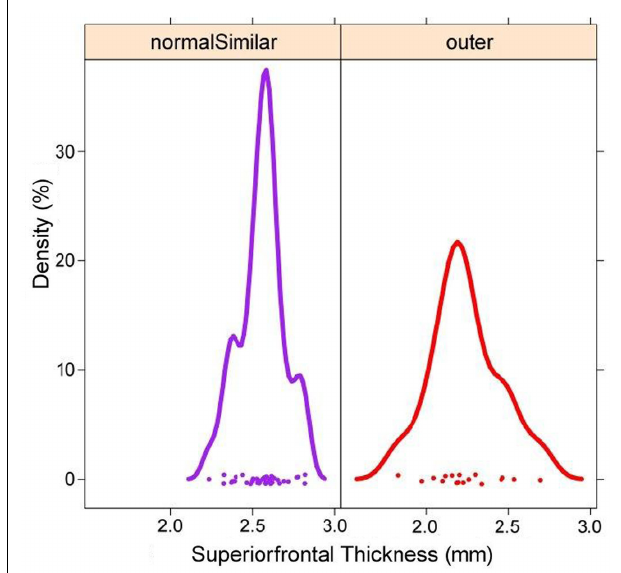
FIGURE 8 | Brain region-specific exploration of the data using linked plots painted by user-defined group. Corresponding to the data represented in Figure 7 , but focusing only on the superior frontal gyrus sub-volumes, histograms for the group consisting of mostly healthy subjects is given (left), while a red group is largely comprised of patients with Alzheimer’s Disease.Thus, from the examination of how brain morphometry clusters in a derived feature space explored using INVIZIAN, a user can quickly and interactively discover that normal subjects exhibits a larger mean thickness in frontal cortices than do patients. Such a hypothesis can be examined more closely by downloading the original data from the database or tested more precisely through the collection of new empirical brain imaging